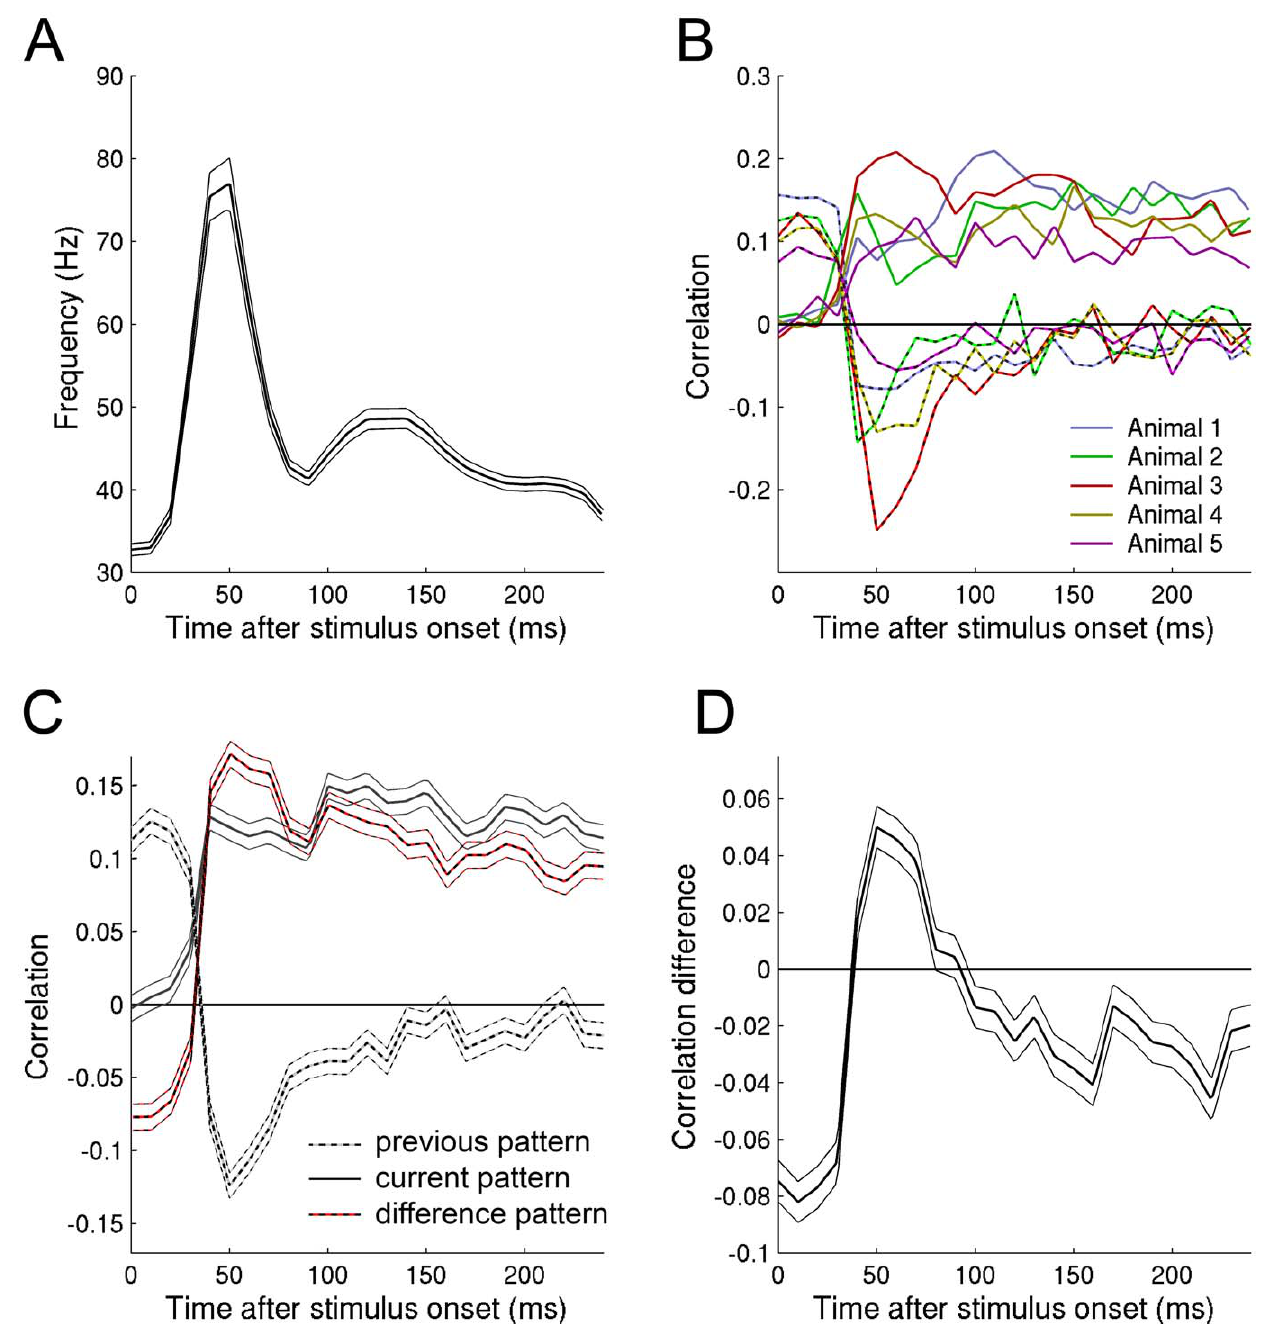
Figure 3. The decoded pattern changes with time. A: The average instantaneous firing rate after a stimulus transition. B: For each time point the decoded pattern was correlated with the current pattern (solid line) and with the previous pattern (dashed line). The average correlation was calculated across all 810 transitions per animal (see legend for color code). C: The correlation was averaged across all five animals and the standard error (thin lines) was calculated across all pattern presentations and animals. The standard error is the standard deviation divided by the square root of the number of data points. D: The correlation with current pattern was subtracted from the correlation with the difference pattern. Before 90 ms the decoded pattern is more correlated with the difference pattern than with the current pattern. After 90 ms the opposite is true.